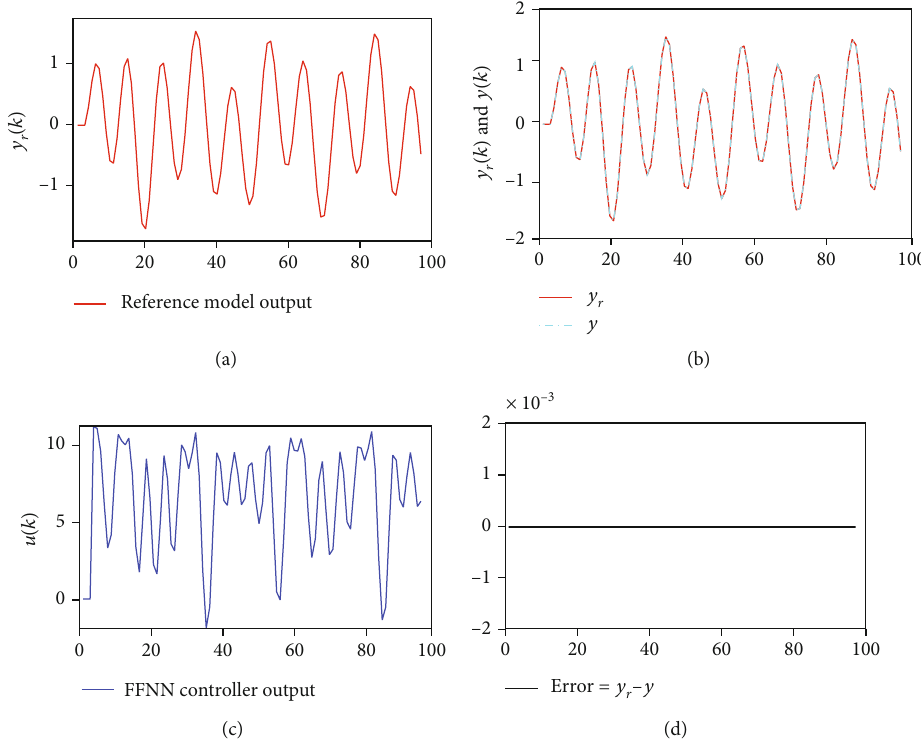
Figure 13: Example 3: (a) response of the reference model, (b) response of the plant under the adaptive controller, (c) FFNN controller output, and (d) control error (using n = 2 and m = 2 ) (online learning).